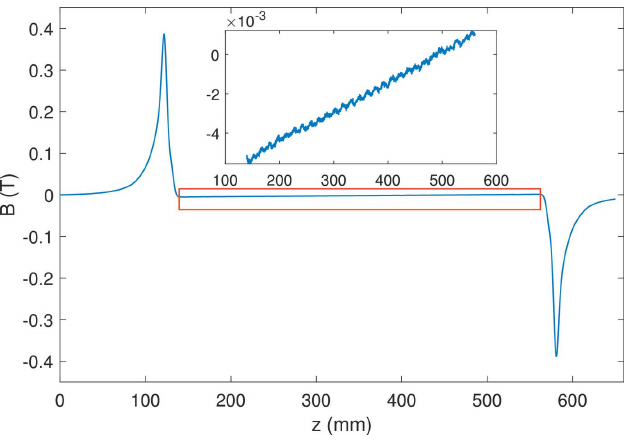
Figure 16 Magnetic field on-axis generated by correction coils with 20 A